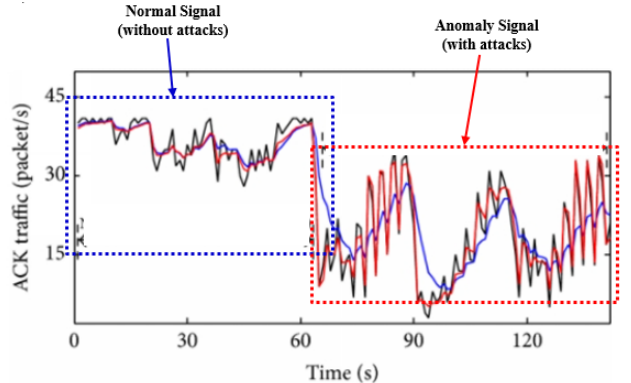
Figure 1. Normal Signal (NS) vs. Anomaly Signal (AS).